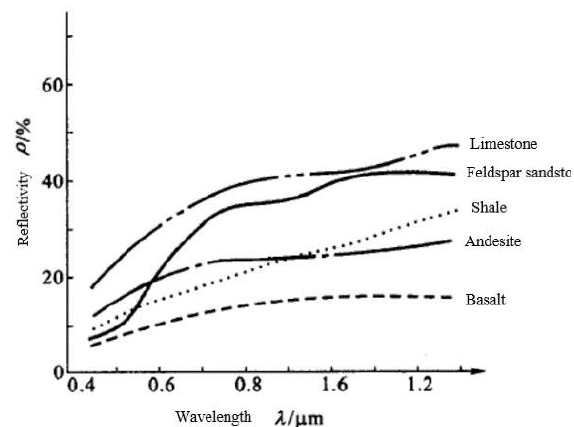
Figure 15. Spectral reflectance curves of